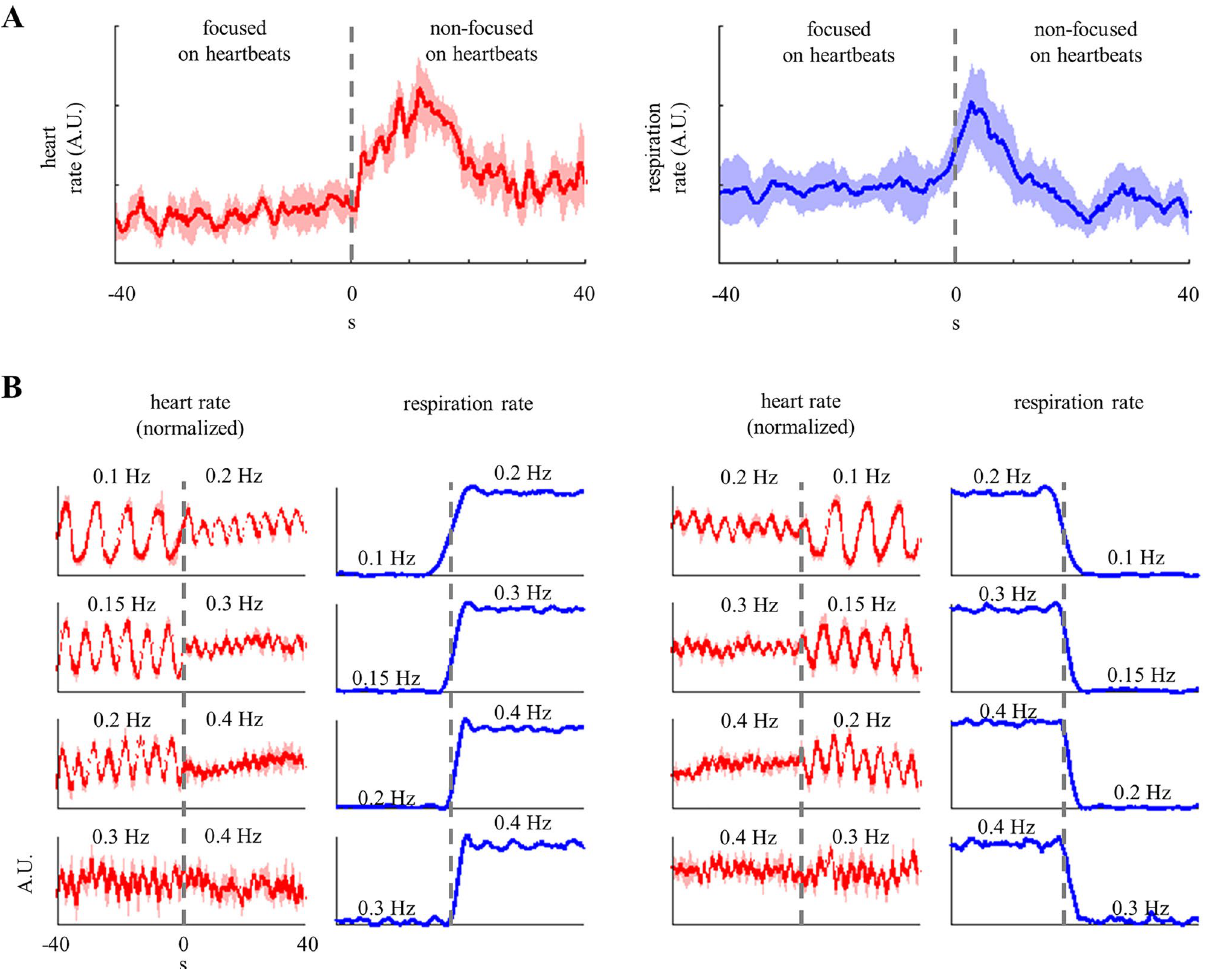
Figure 3. Respiratory modulations induced on heart rate. ( A ) Group median + MAD representing relative change in heart and breathing rates, triggered by the transition from the performance to the cessation of focusing on heartbeats. Heart rate data were smoothed using a 10-s moving mean window and a sample step of 1. Each subject data corresponded to an average over six trials. ( B ) Relative change in heart (group median + MAD) and breathing rates during slower-to-faster and faster-to-slower transitions. Each subject data corresponded to the average over the two trials for each transition. All signals represent the group median ± median absolute deviation. All signals used for computing the medians were the rates expressed in Hz, the z-score was normalized per subject over a window of − 50 to 50 s with respect to each transition in breathing